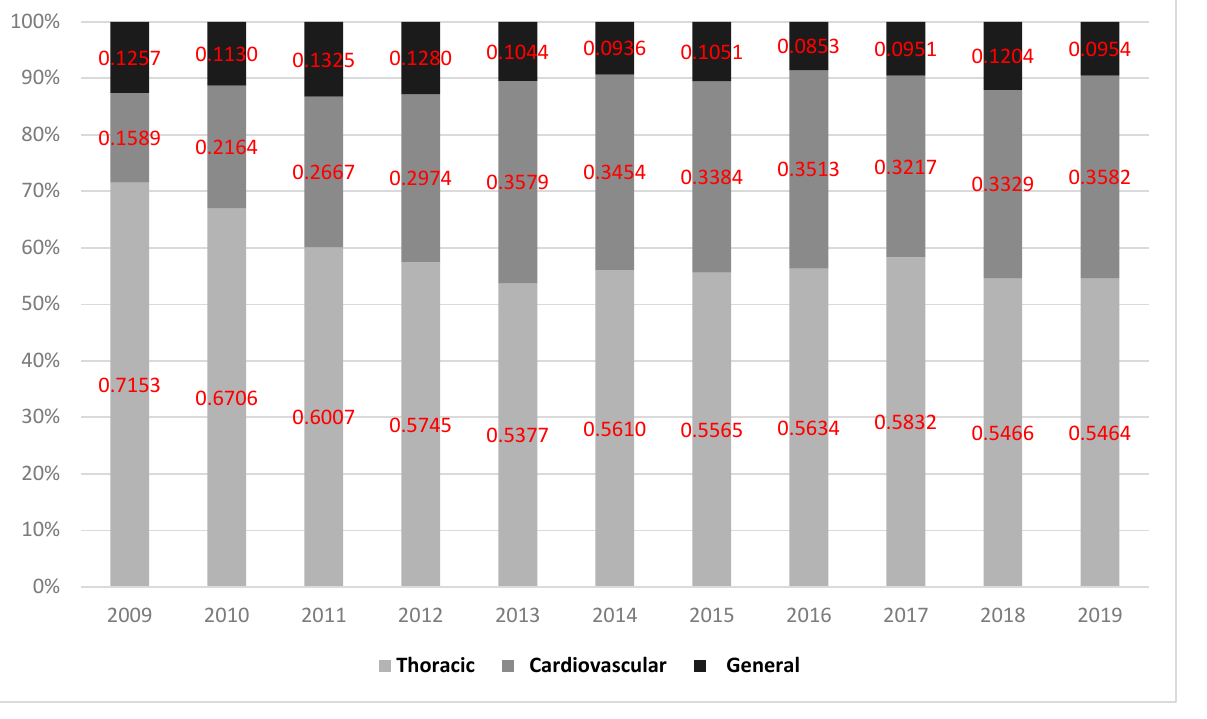
Figure 3. Proportion of lung lobectomies performed by each provider type in the Premier Healthcare Database from 2009 to 2019.